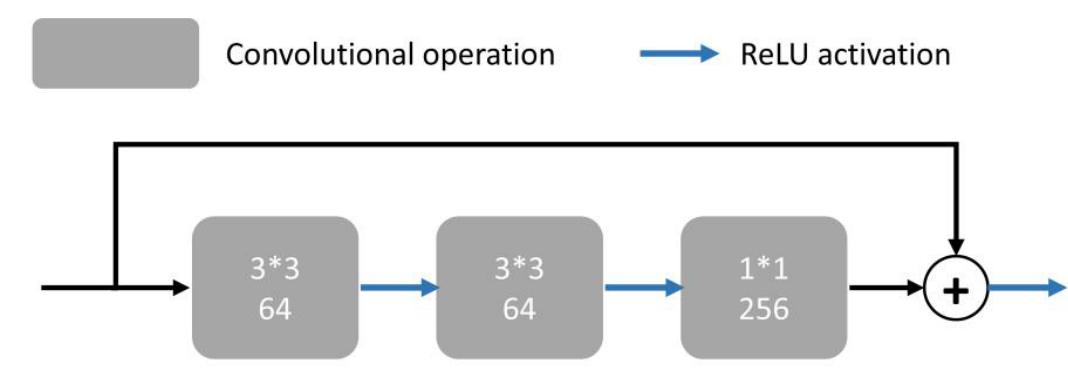
Figure 6. Bottleneck block.